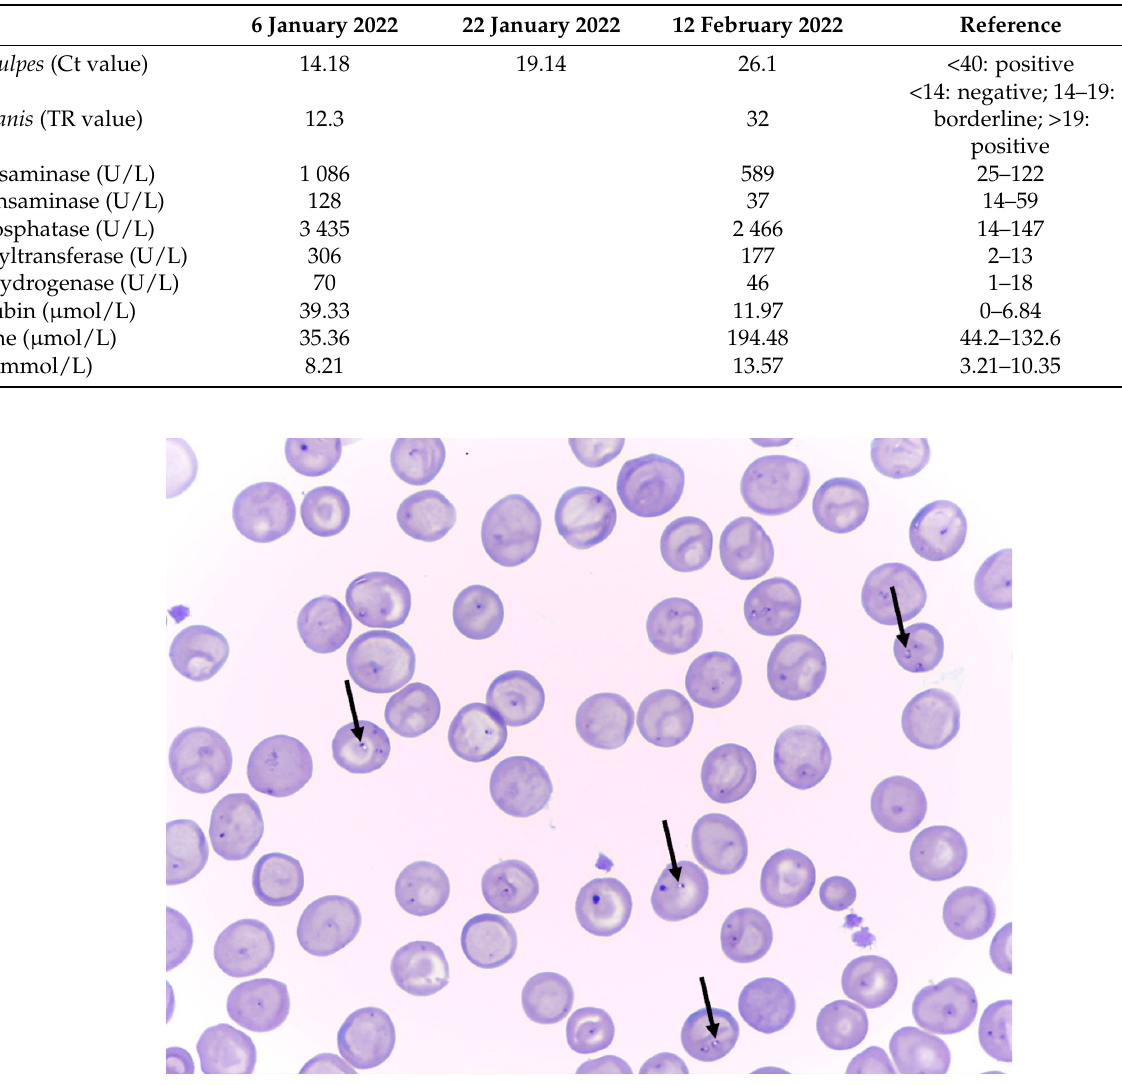
Figure 2. Diff-Quick stained peripheral blood smear before treatment against Babesia vulpes . Black arrows indicate B. vulpes .